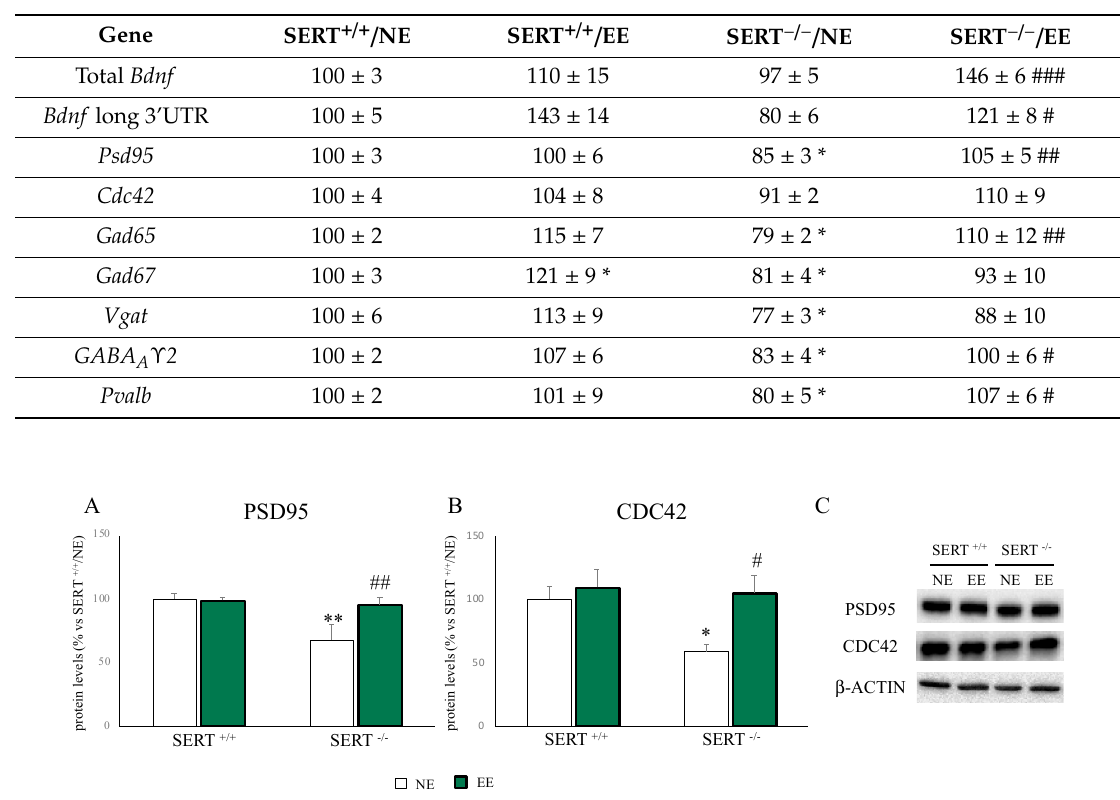
Figure 3. Analyses of mBDNF protein levels in the PFC of SERT +/+ and SERT − / − rats subjected to one Table 3. Analyses of Bdnf , spine, and GABAergic markers mRNA levels in the PFC of SERT +/+ and month of exposure to NE (normal environment) or EE (environmental enrichment) ( A ) and its SERT − / − rats subjected to one month of exposure to NE or EE. The data are presented as percent representative western blot bands ( B ). The data are presented as percent change of SERT +/+ /NE and change of SERT +/+ / NE and are expressed as mean ± standard error of the mean (SEM). * p < 0.05 vs. are expressed as mean ± standard error of the mean (SEM). * p < 0.05, vs. SERT +/+ /NE; two-way SERT +/+ / NE; # p < 0.05, ## p < 0.01, ### p < 0.001 vs. SERT − / − / NE two-way ANOVA with PLSD. ANOVA with PLSD.